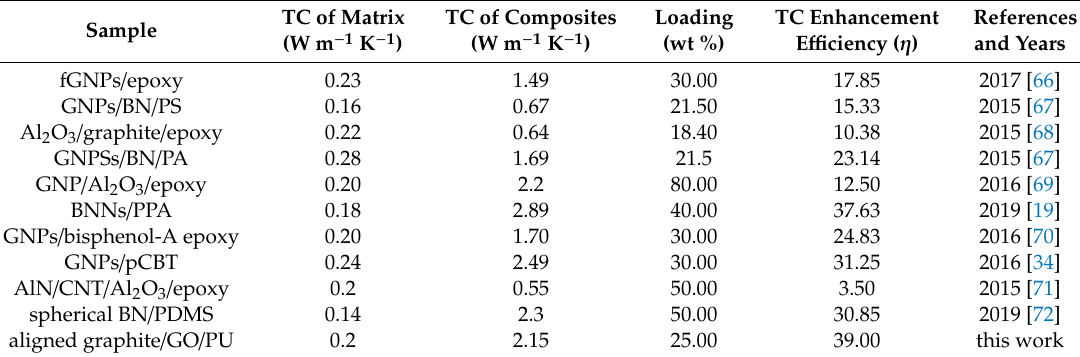
Table 1. Summary of the TC of polymer composites filled with di ff erent fillers.